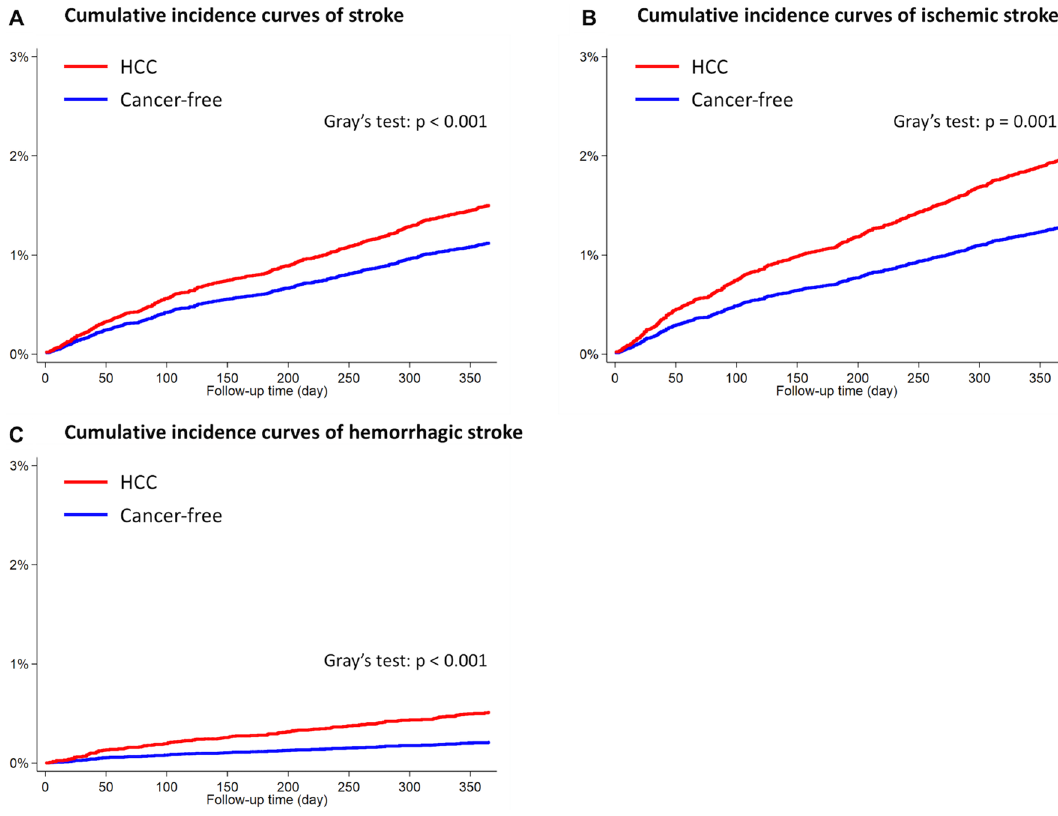
Figure 1. Cumulative incidence curves of stroke in patients with HCC and cancer-free individuals. (A) Stroke overall; (B) ischemic stroke; (C) hemorrhagic stroke. HCC hepatocellular carcinoma.